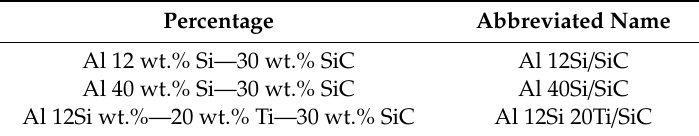
Table 2. Cladding powder proportions.